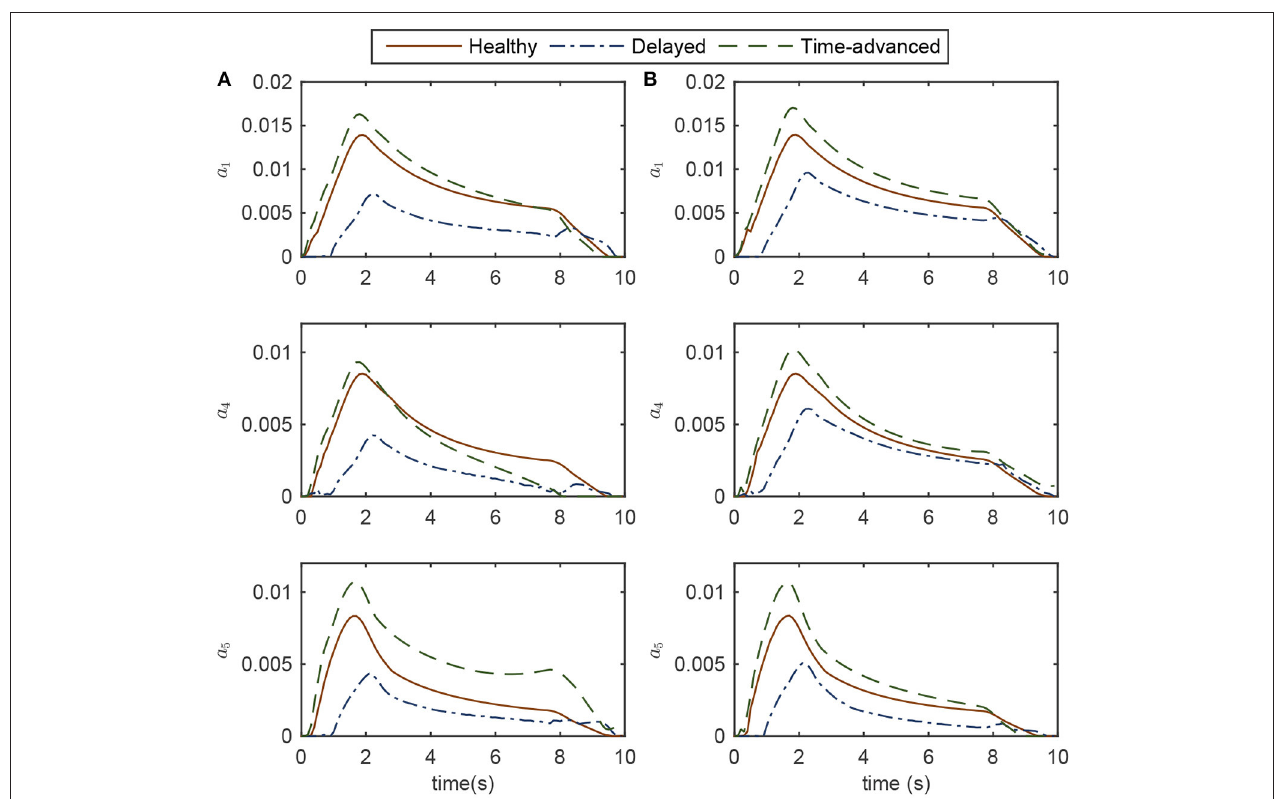
FIGURE 4 | Activations of the active muscles in three modes of simulation while controlling the robot (A) OIC, and (B) SOIC. Note that in the impaired mode, muscle activations are